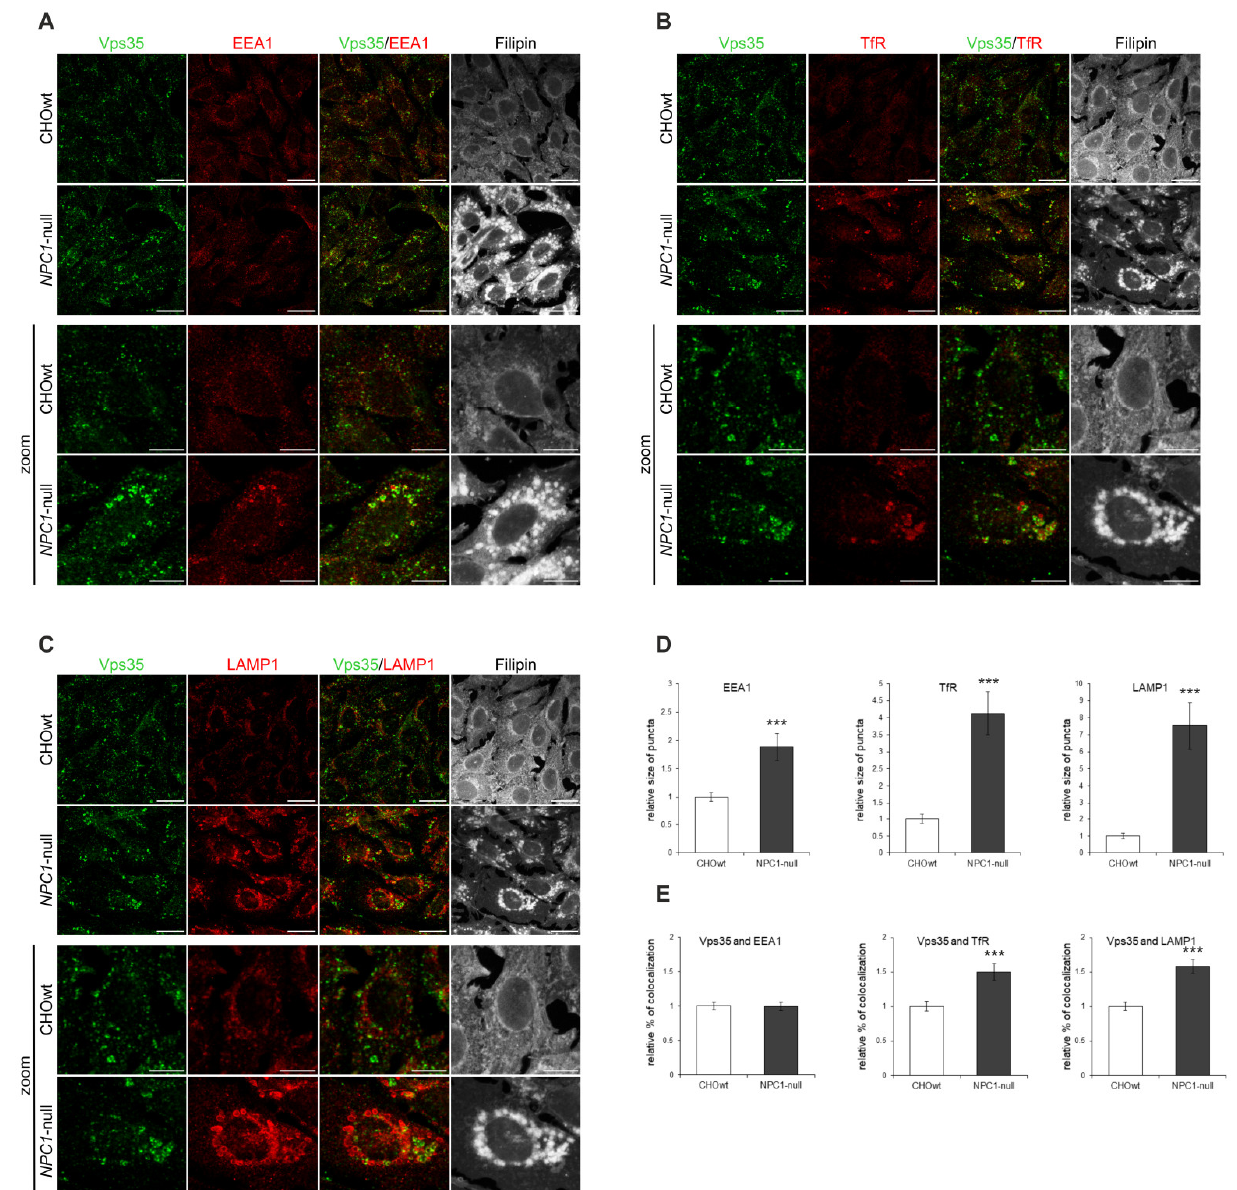
Figure 2. Retromer trafficking within the endolysosomal pathway is altered in NPC1 -null cells. Trafficking of the retromer protein Vps35 in CHOwt and NPC1 -null cells was monitored by immunofluorescence ( A – C ), and the obtained signals were quantified using ImageJ software ( D , E ). The cells were grown in 10% FBS in DMEM/F12 media, fixed and stained for Vps35 (green) and ( A ) early endosome marker EEA1 (red), ( B ) recycling endosome marker transferrin receptor (TfR, red) and ( C ) lysosome marker LAMP1. Filipin was used to stain free cholesterol. ( D ) Size of EEA1, TfR and LAMP1-positive puncta and ( E ) colocalization of Vps35 with EEA1, TfR and LAMP1 were compared between CHOwt and NPC1 -null cells, *** p < 0.001. The data are shown as mean ± SD normalized to control, n = 30 cells per group from three inde- pendent experiments. Scale bar—20 (unzoomed images) and 10 µm (zoomed images).